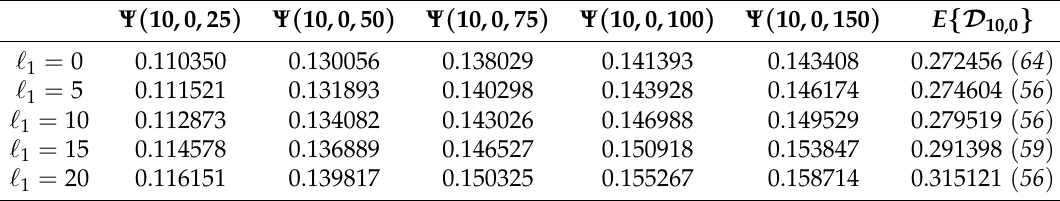
Table 2. Finite-time ruin probabilities and expected total discounted dividends paid prior to ruin